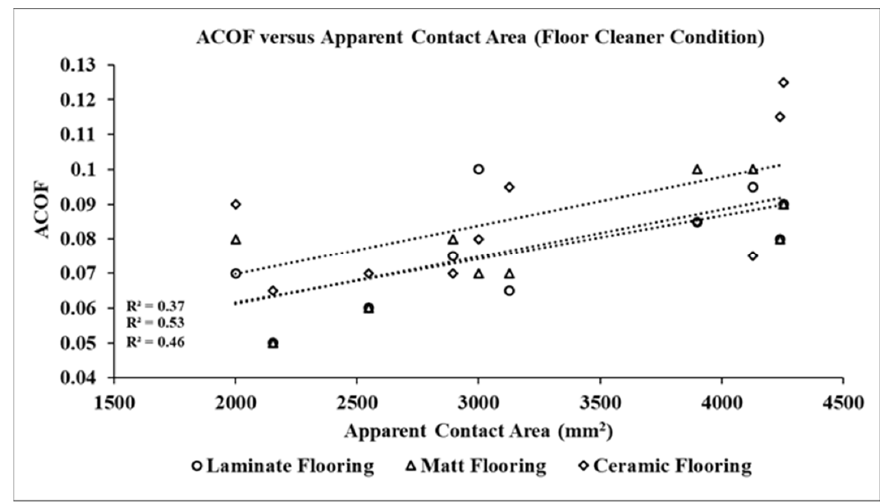
Figure 9. Correlation between apparent contact area and ACOF across tested shoes in the floor cleaner contaminant condition.